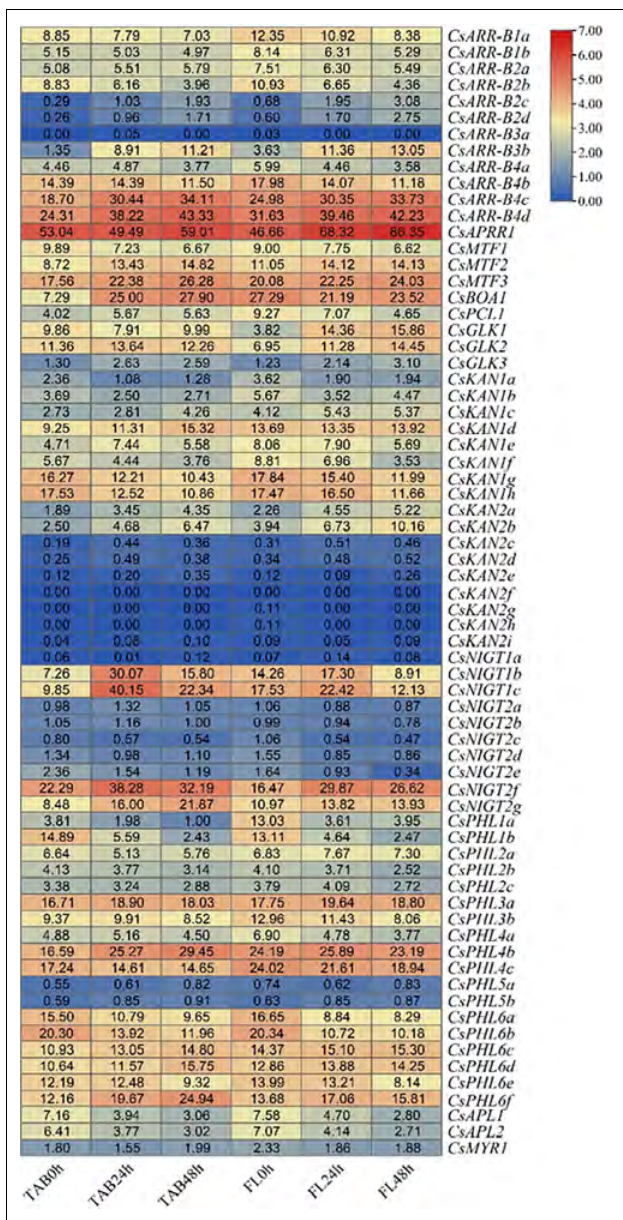
FIGURE 10 | Expression analysis of CsGARPs in response to cold stress in FL and TAB tissues. The expression levels of CsGARPs were calculated with TPM values. The red and blue colors represent high and low expression levels,